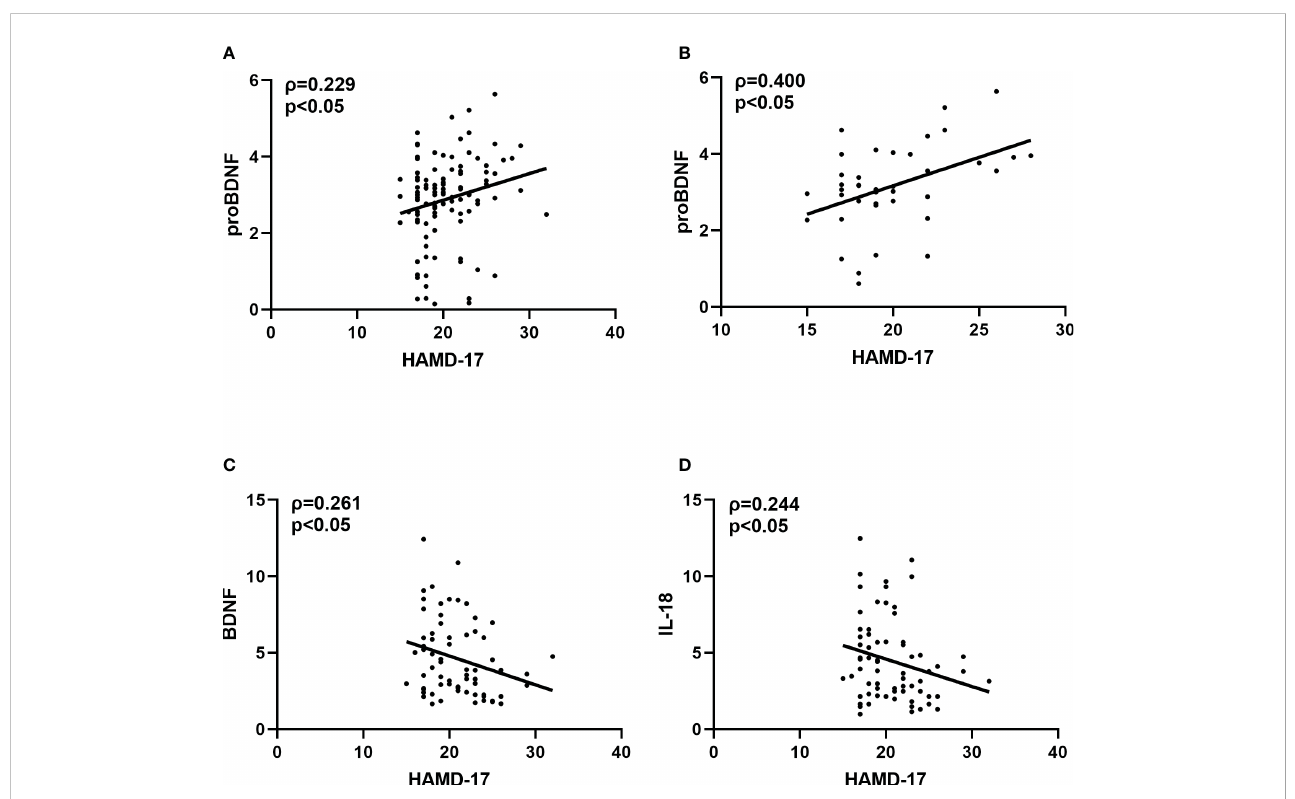
FIGURE 2 (A) Correlation between HAMD-17 and proBDNF in overall MDD patients. (B) Correlation between HAMD-17 and proBDNF in male MDD patients. (C) Correlation between HAMD-17 and BDNF in female MDD patients. (D) Correlation between HAMD-17 and IL-18 in female MDD patients. HAMD-17, 17- item Hamilton Depression Rating Scale proBDNF, brain-derived neurotrophic factor precursor; BDNF, brain-derived neurotrophic factor IL,